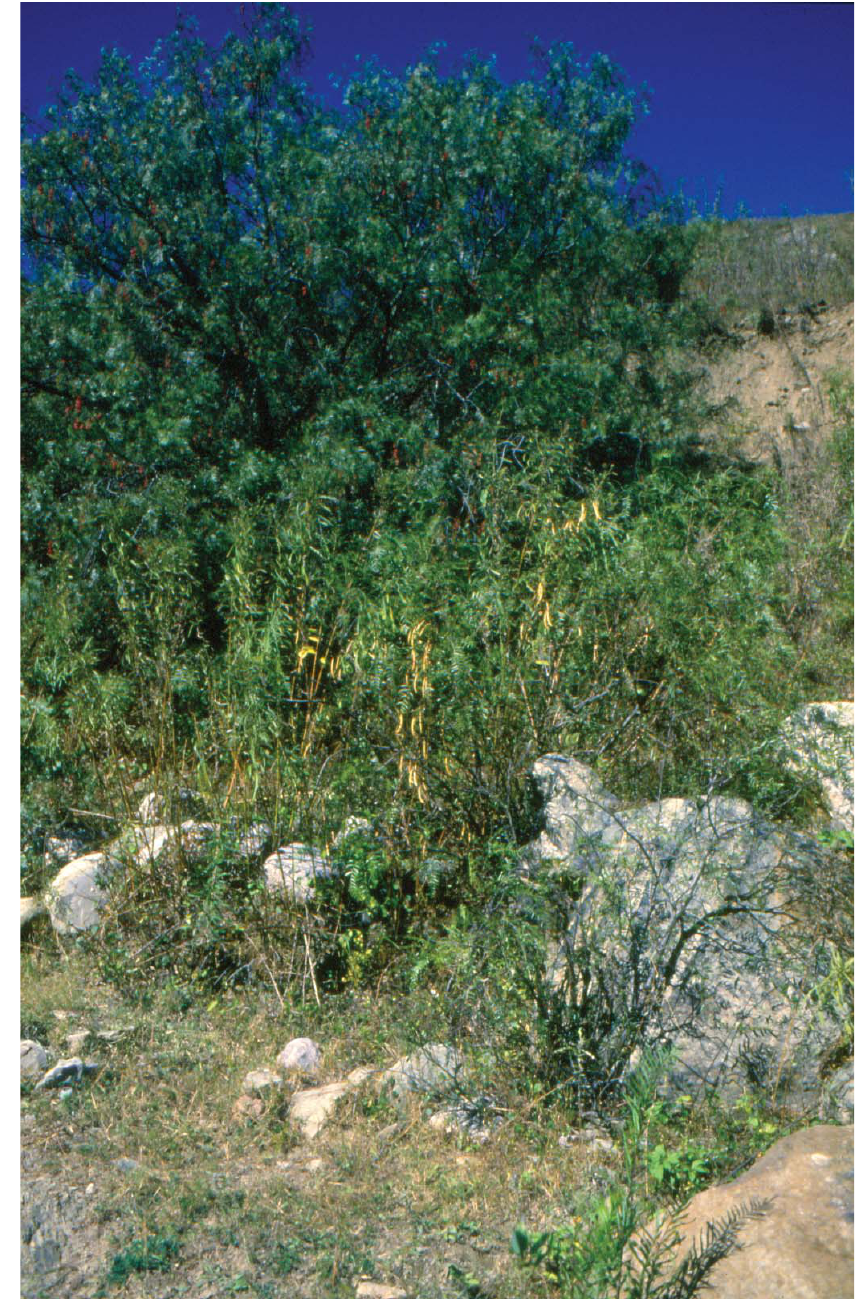
Figure 1. A wild P. vulgaris population (#1715) on an open sunny slope of arroyo Santa Victoria, Salta, Argentina, with its ripe golden pods, sampled in April